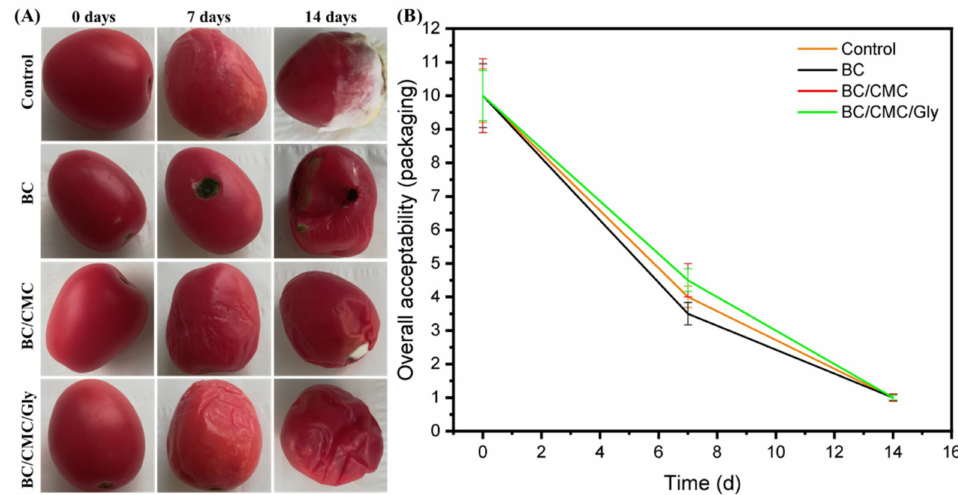
Figure 7. The results of preliminary analysis of ( A ) fruit coating and ( B ) evaluation of acceptance for the control (uncoated tomatoes) and pristine BC, BC/CMC, and BC/CMC/Gly films evaluated at 30 ◦ C for two